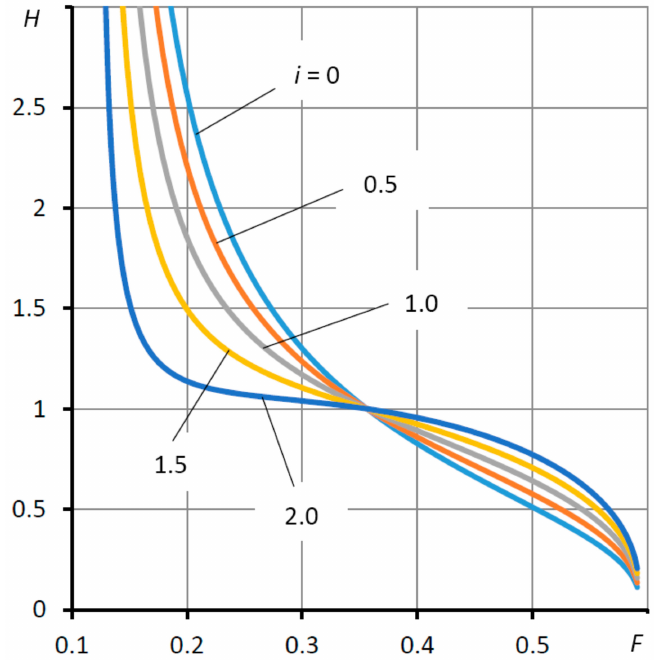
Figure 5. Dependences of the gap H on the external force F of the thrust bearing at various values of the elasticity coefficient K e = i K e 0